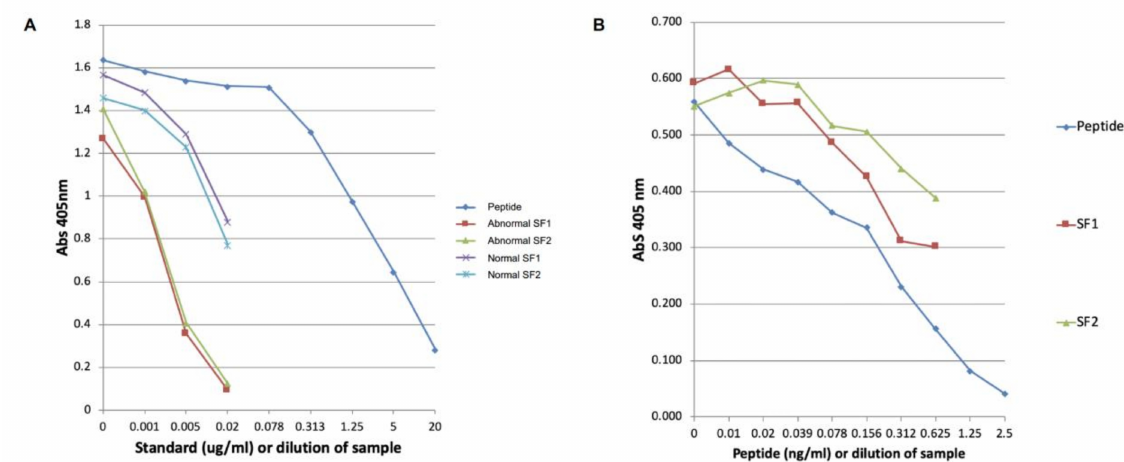
Figure 3. Parallel inhibition curves for ( A ) original neoepitope assay and ( B ) modified assay including spanning peptide to block cross-reactivity of the neoepitope antiserum with intact COMP. Both normal and abnormal synovial fluids show good parallel inhibition in both assays.